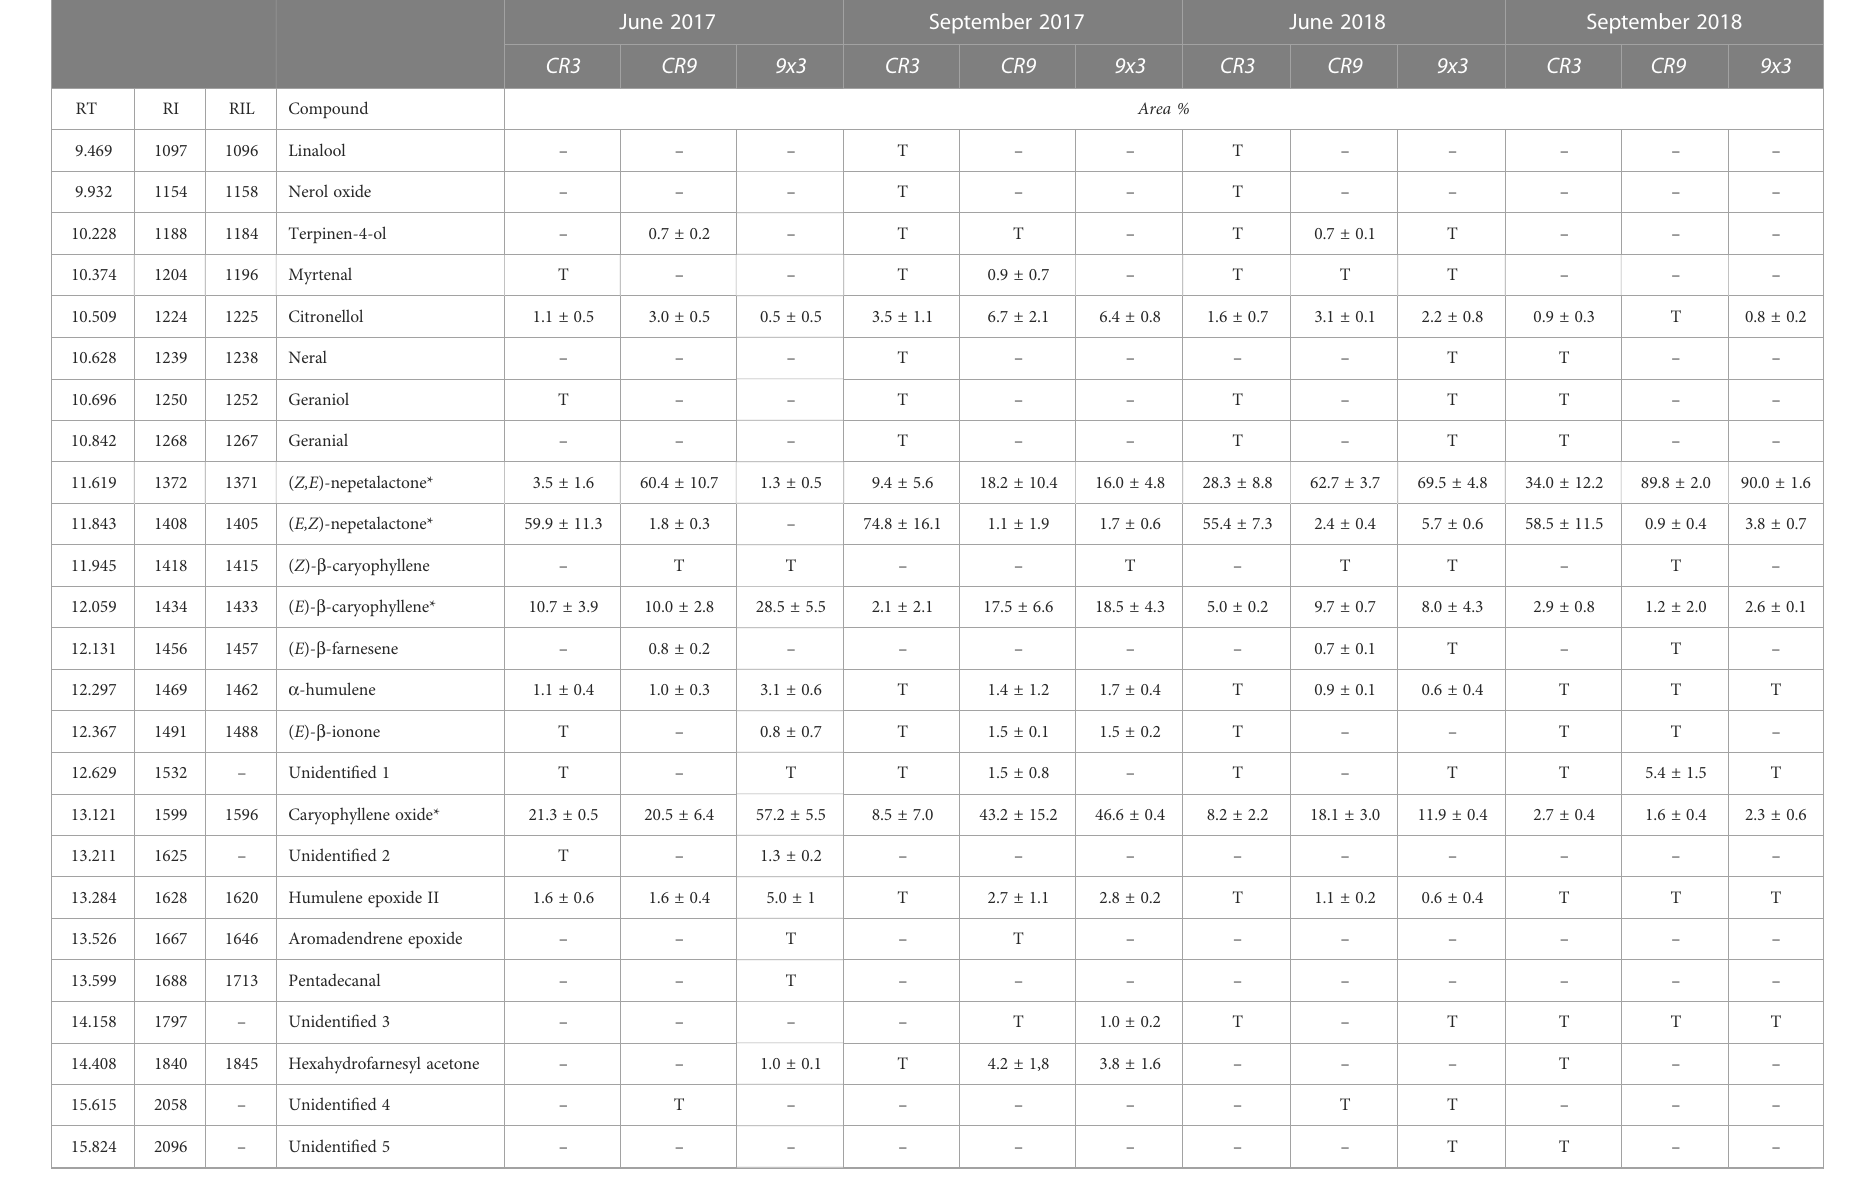
TABLE 3 Chemical constituents and relative percentages of total chromatogram area of essential oils from different genotypes of catnip ( Nepeta cataria L.) across 4 successive harvests in the years of 2017 and 2019. Pittstown, NJ, United